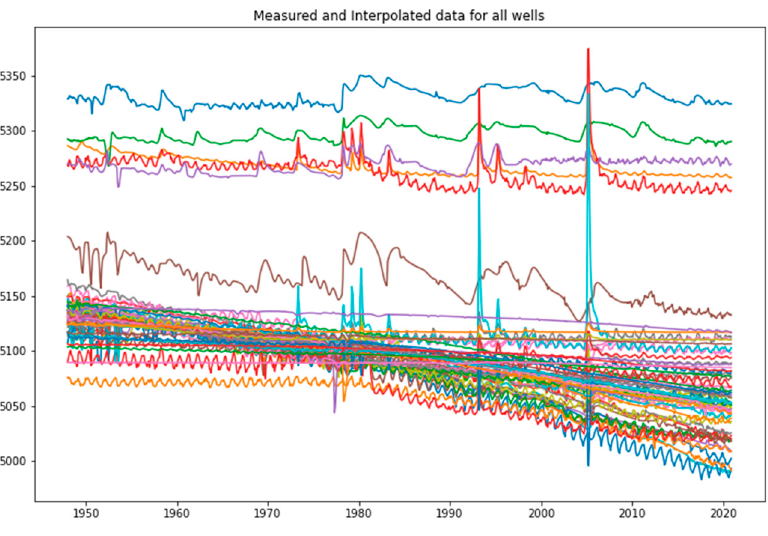
Figure 14. All wells from the Beryl-Enterprise aquifer with imputed values.